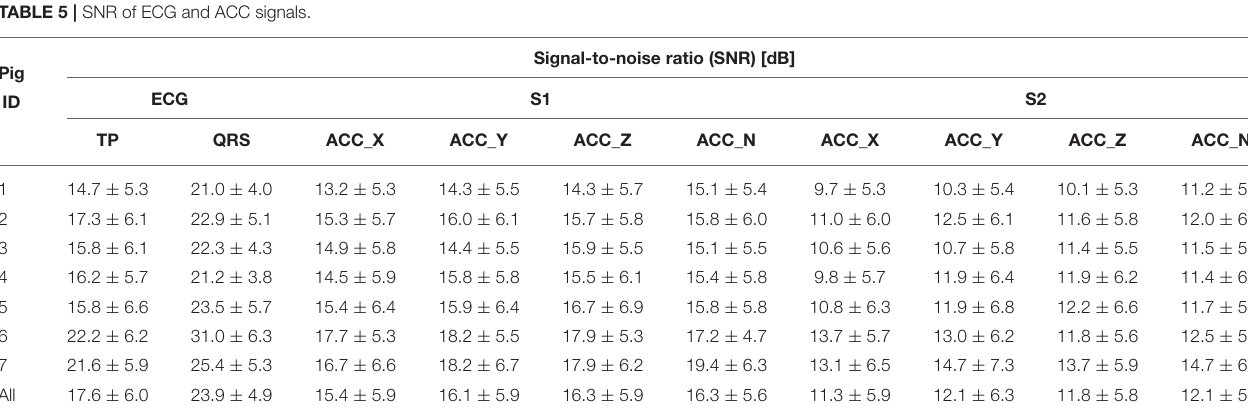
TABLE 5 | SNR of ECG and ACC